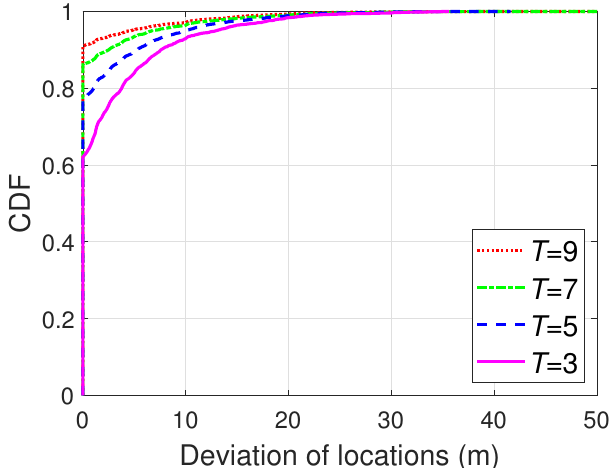
Figure 5. CDF of deviation of retrieved locations with different T